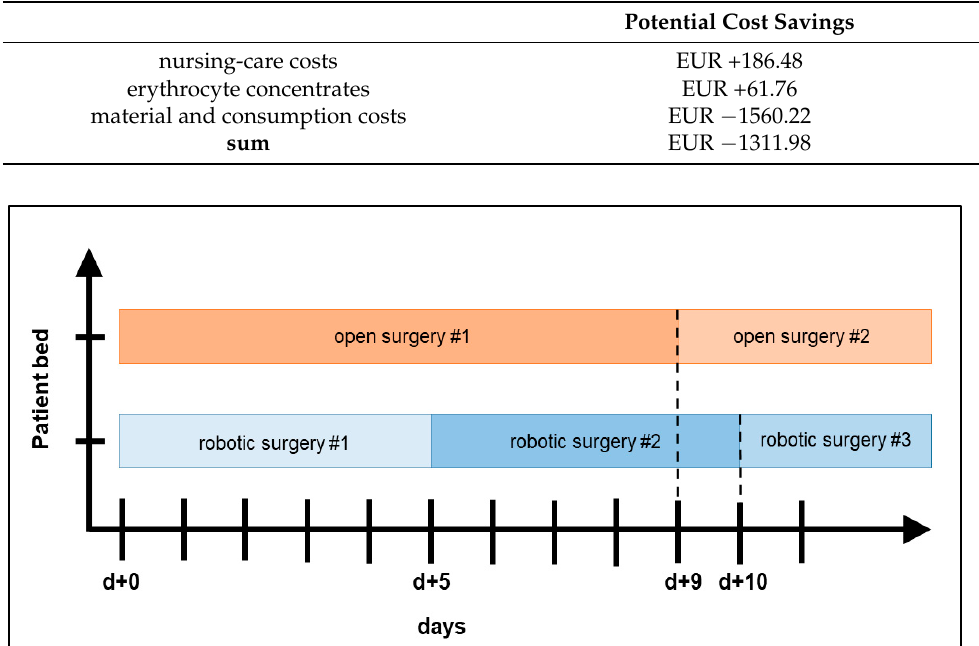
Table 5. Overview of the case-related savings potential of robotic partial nephrectomy.